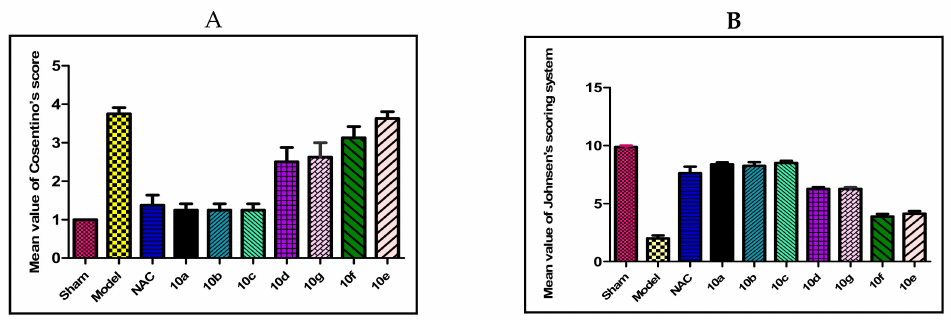
Figure 9. The histopathological findings of ( A ); Cosentino’s score, ( B ); Johnson’s scoring. Results were represented by the mean ± SE ( n =